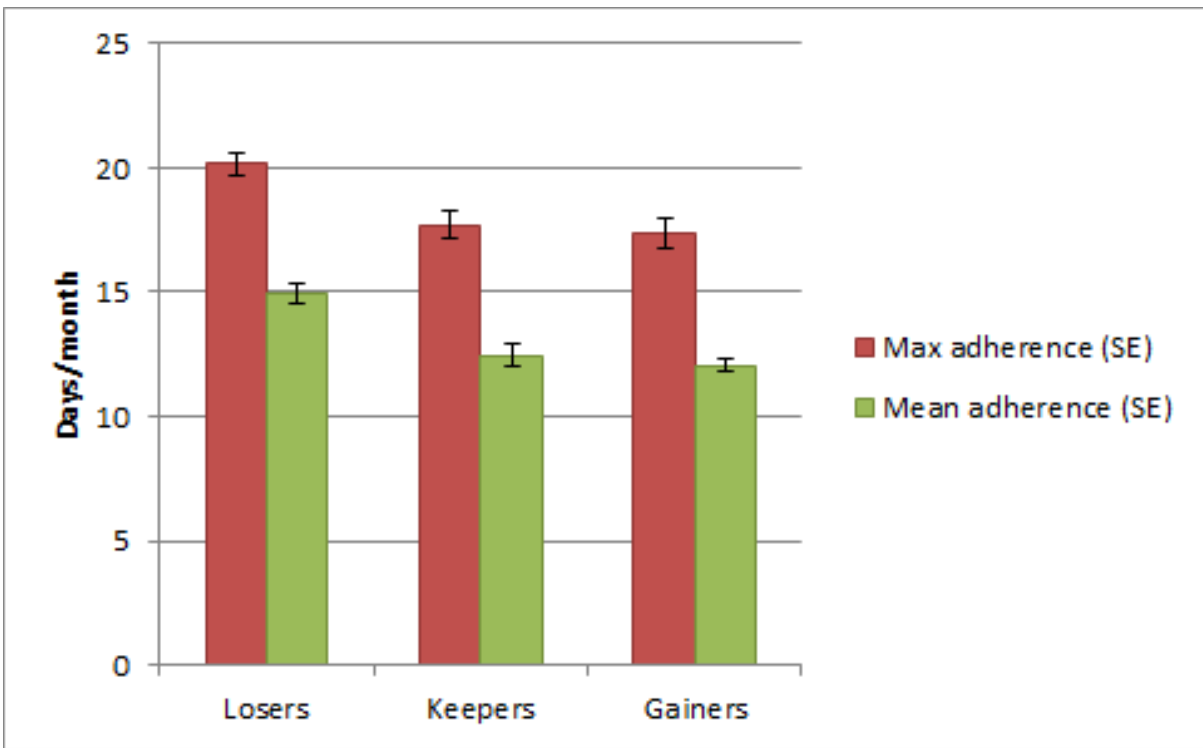
Figure 2. Adherence to three changes among participants who lost, maintained, or gained weight between any two surveys.